Question: What does this figure show? Answer in one sentence.
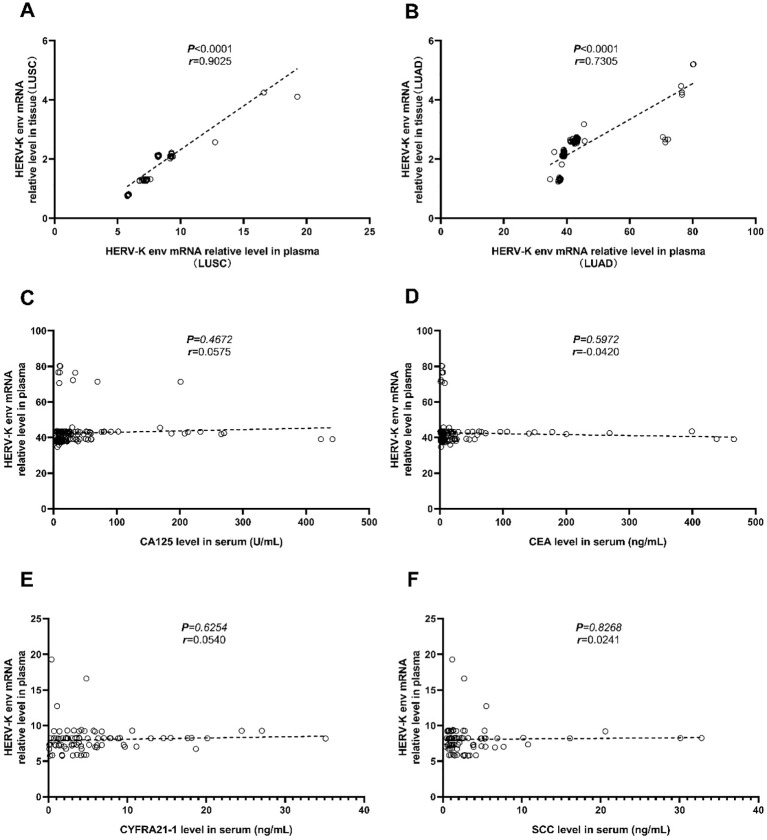
Answer: Analysis of the correlation between plasma HERV-K env mRNA expression levels, tumor tissue expression levels, and conventional serum tumor markers in lung cancer patients. (A) Correlation between plasma and tumor tissue HERV-K env mRNA levels in patients with lung squamous cell carcinoma (LUSC). (B) Correlation between plasma and tumor tissue HERV-K env mRNA levels in patients with lung adenocarcinoma (LUAD). (C) Correlation between serum CA125 levels and plasma HERV-K env mRNA levels in LUAD patients. (D) Correlation between serum CEA levels and plasma HERV-K env mRNA levels in LUAD patients. (E) Correlation between serum CYFRA21–1 levels and plasma HERV-K env mRNA levels in LUAD patients. (F) Correlation between serum SCC levels and plasma HERV-K env mRNA levels in LUSC patients. Correlations were analyzed using Pearson’s correlation coefficient (r) , with two-tailed P-values indicating statistical significance. Linear regression was performed to visualize relationships with dashed regression lines.